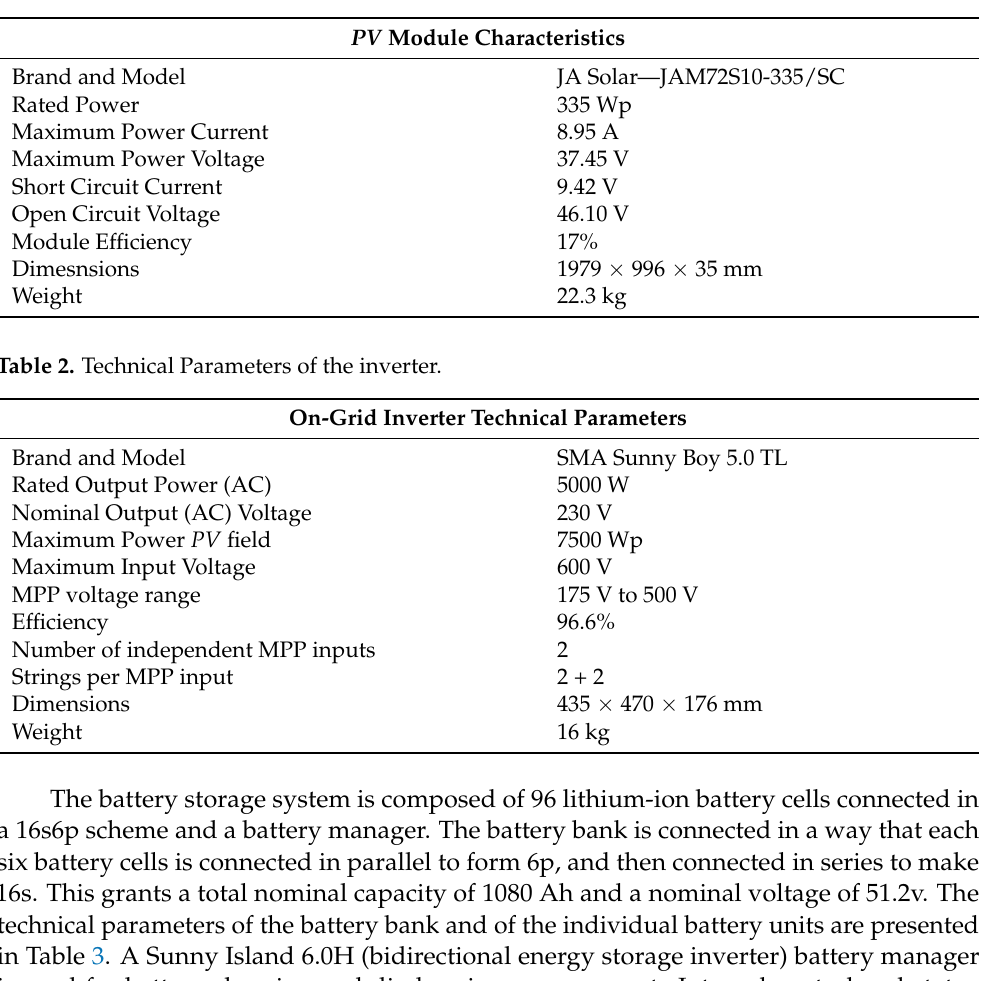
Table 1. Technical Parameters of PV Module.